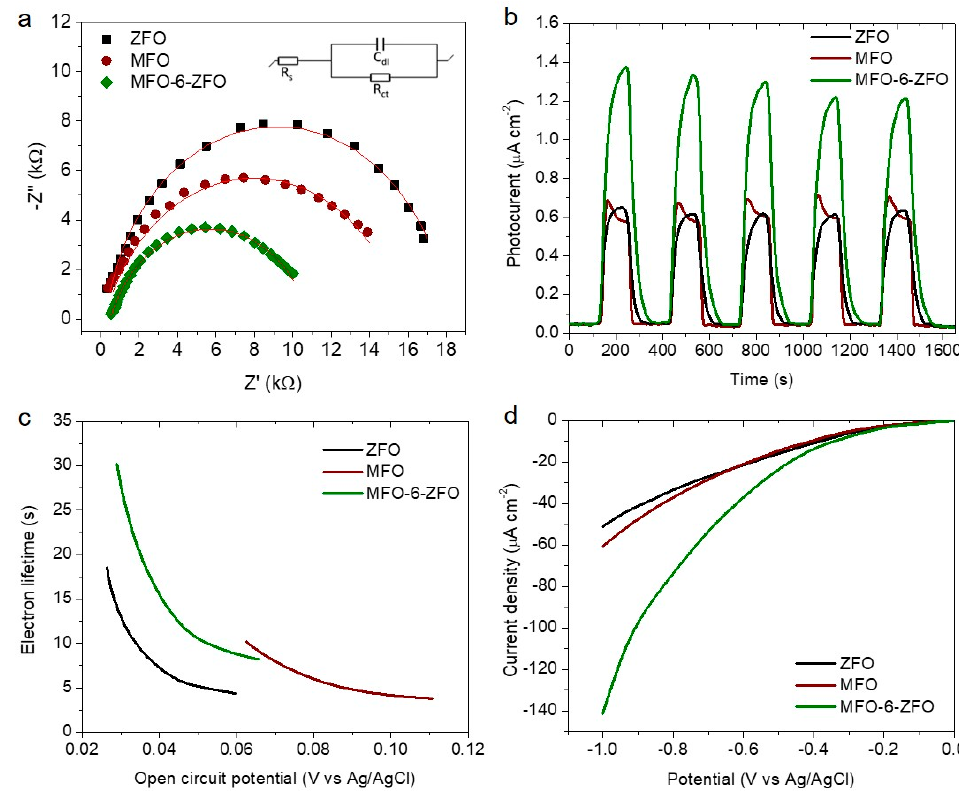
Figure 6. ( a ) Electrochemical impedance spectra (Inset: Equivalent circuit used for data analysis; C dl —double layer capacitance, R ct —charge-transfer resistance, R s —electrolyte resistance), ( b ) tran- sient photocurrent responses, ( c ) electron lifetime determined from the OCP decay curves, and ( d ) polarization curves of ZFO, MFO, and MFO-6-ZFO MNAs catalysts. In panel ( a ), the red lines are fit to the data.